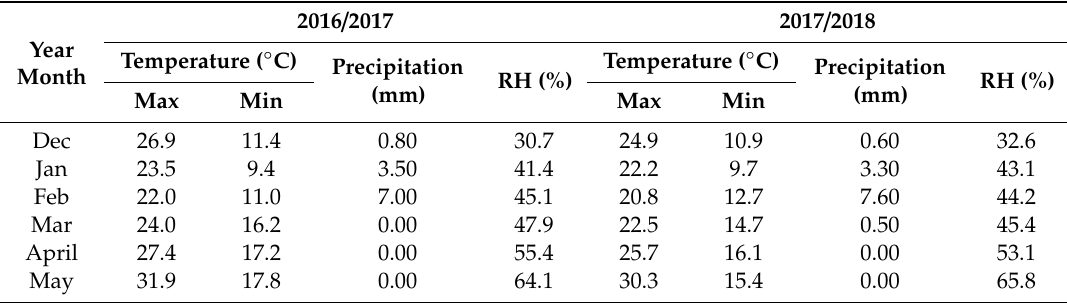
Table 1. Meteorological data for the two winter growing seasons 2016 / 2017 and 2017 / 2018.